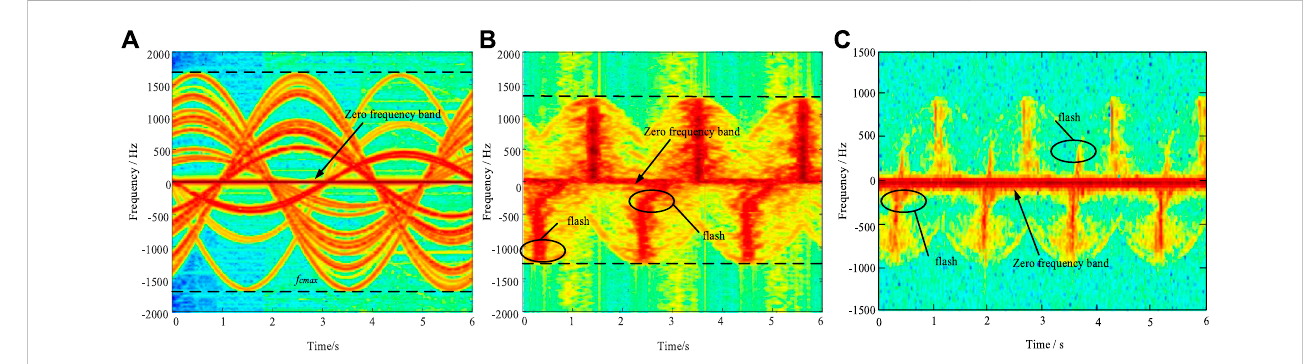
FIGURE 7 Comparisonoftimeandfrequencydomainechoofbladesobtainedbydifferentmethods. (A) Integralalgorithmbasedonscatteringcenter, (B) proposed method, (C) measured data.